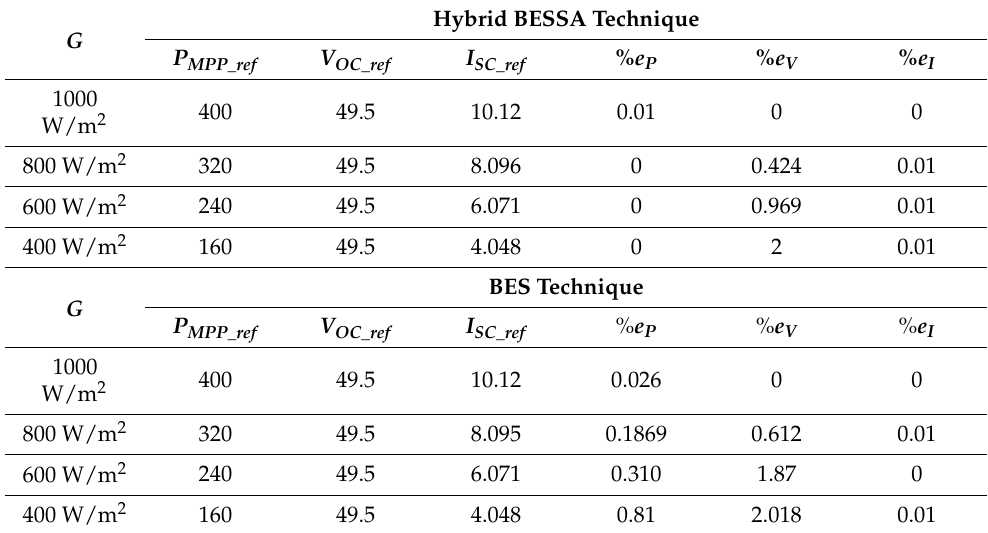
Table 11. Reference values and percentage error for the PV Module AS-M3607-S(G1 CELLS) obtained using the Hybrid BESSA- and BES-based parameter extraction techniques with G varying from 1000 W/m 2 to 400 W/m 2 while keeping T fixed at 25 ◦